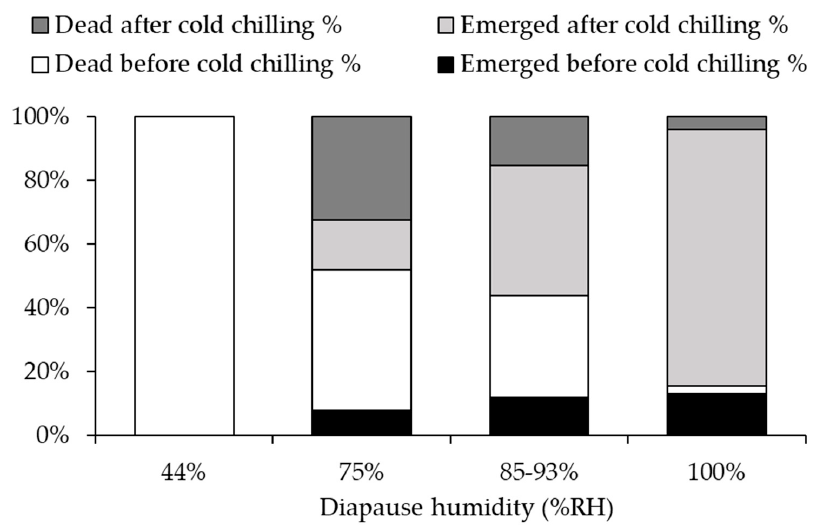
Figure 4. Survival and emergence of A. fukutai larvae pre- and post-cold chilling at different humidity conditions (see Table 1). Values are the percentage of emerged and dead individuals within the parasitized A. chinensis eggs.